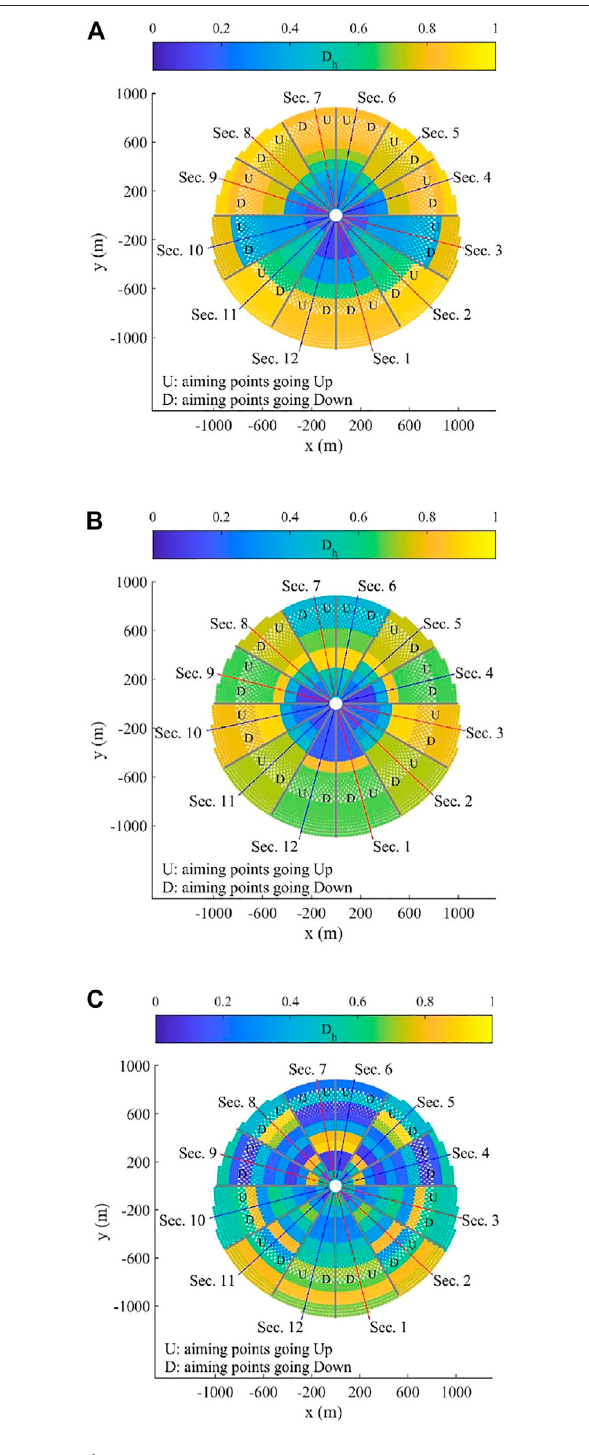
FIGURE 6 | Values for D h after optimization (A) Con fi guration 1 (B) frac Con fi guration 2 (C) Con fi guration 3.